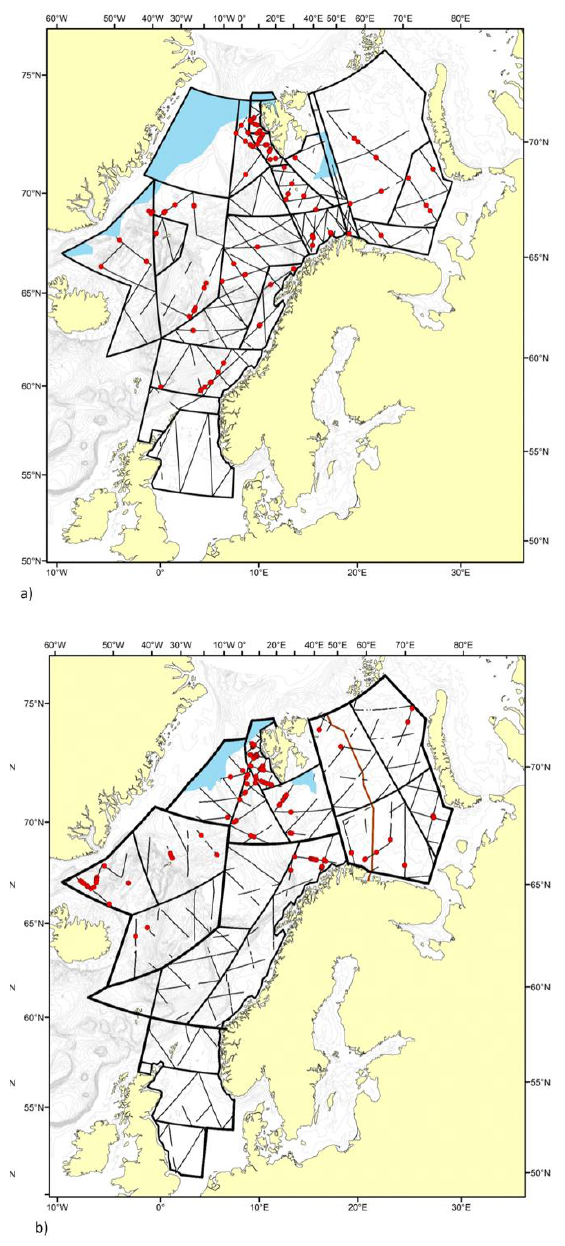
Figure 3. Distributions of sightings recorded as fin whales during (a) the 2002 – 2007 surveys and (b) the 2008 – 2013 surveys. The blue areas represent ice coverage.